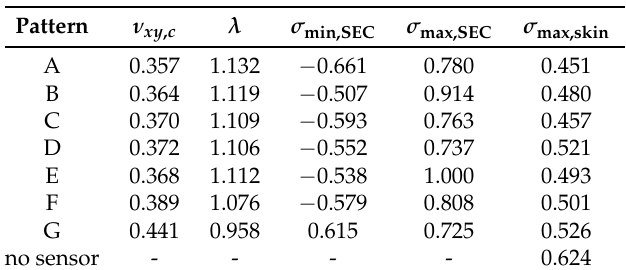
Table 3. Composite transverse Poisson’s ratio ν xy , c , corresponding gauge factor λ (Equation (7)), minimum stress at the sensor level ( σ min,SEC ), maximum stress at the sensor level ( σ max,SEC ), and maximum stress at the skin level ( σ max,skin ) under Patterns A to G. All stress values are normalized to | σ | max =